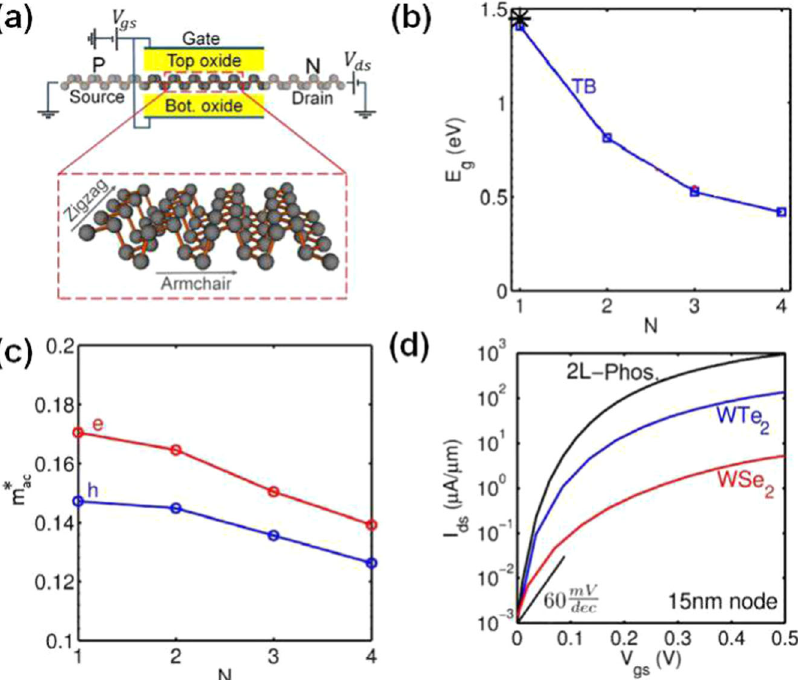
Fig. 15 Simulation Report of Nanoscale 2D Ph-TFET. a Schematics of Phosphorene-based TFETs, Layer dependent b band-gap, c armchair direction effective masses, and d comparative transfer characteristics of Ph- and TMD- TFETs, adapted with permission from 102 . Copyright (2016) Nature.